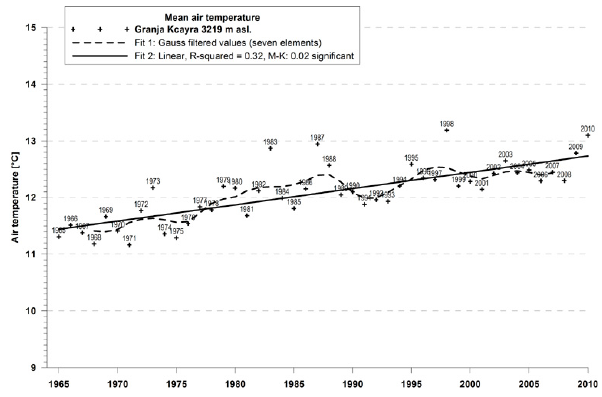
Figure 10. Air temperature and linear and gaussian low- pass filtered trends for the homogeneous time series of Granja Kcayra ( − 13.56 ◦ S, − 71.88 ◦ E, 3219ma.s.l.). Linear trend is 0.3 ◦ Cdecade − 1 between 1965 and 2010. This trend is significant at the 0.02 level with Mann-Kendall test.